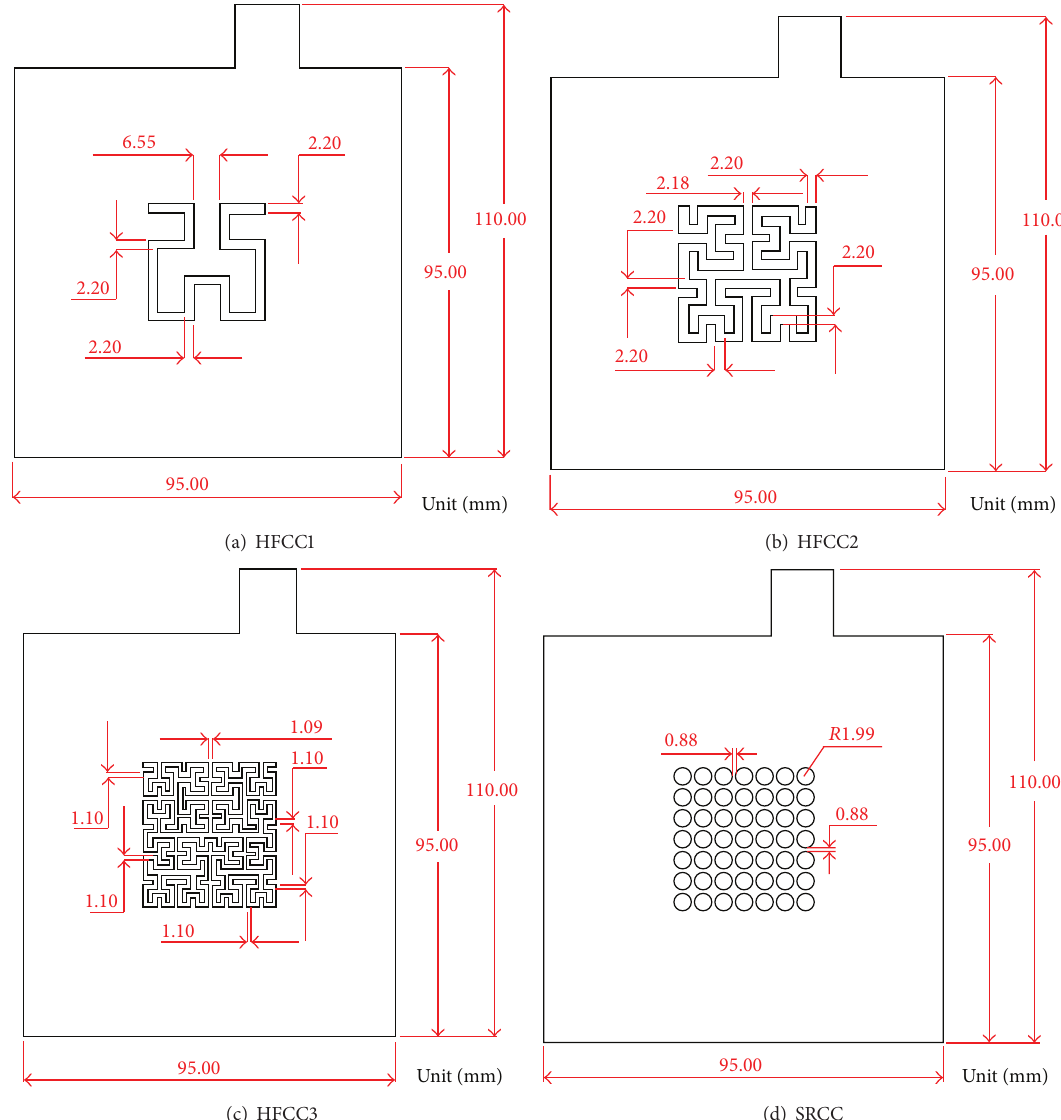
Figure 1: Hilbert curve fractal current